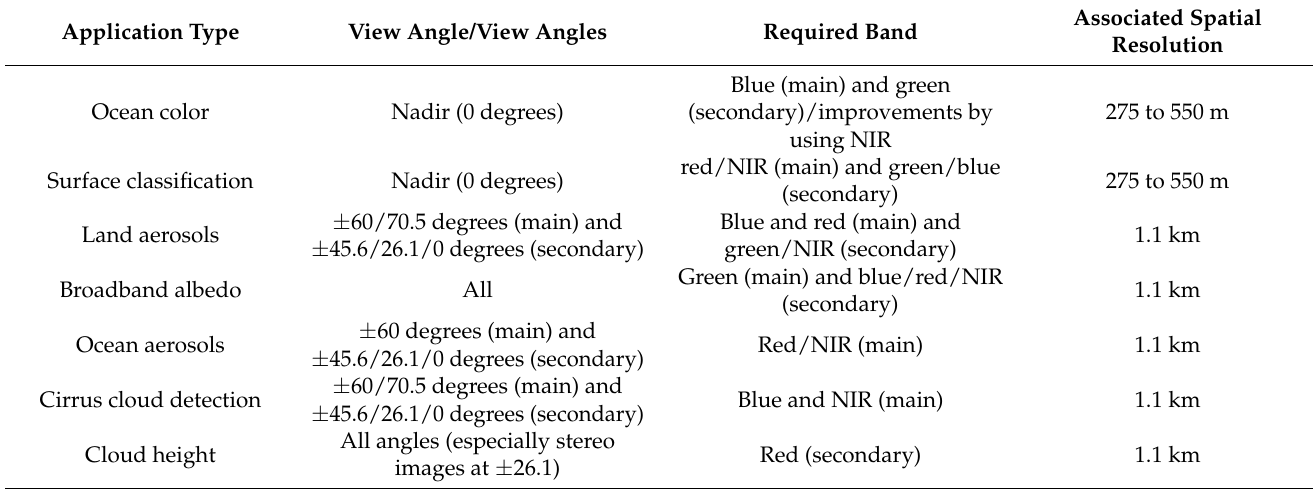
Table 1. HORUS main applications and requirements in terms of angle, band, and spatial resolution. Application